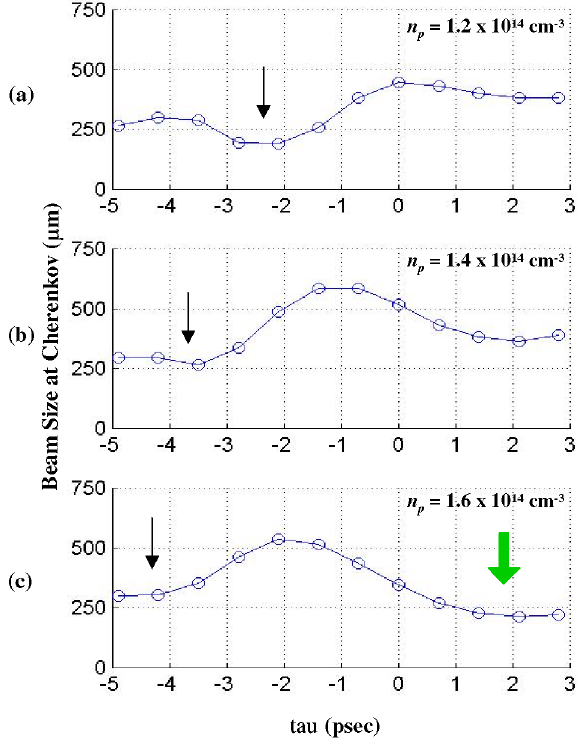
FIG. 7. (Color) Results of the fitting analysis of sectioned Cherenkov-plane images (see text). The horizontal axis is time and the vertical axis is the beam size at the Cherenkov radiator. The graphs increase in density from top to bottom. The minimum, denoted by the black arrows, moves earlier in time as the density increases. Also graph (c), the highest density, shows a second minimum (seen along the entire portion of the beam in blowout) beginning to form, denoted by the larger green arrow.